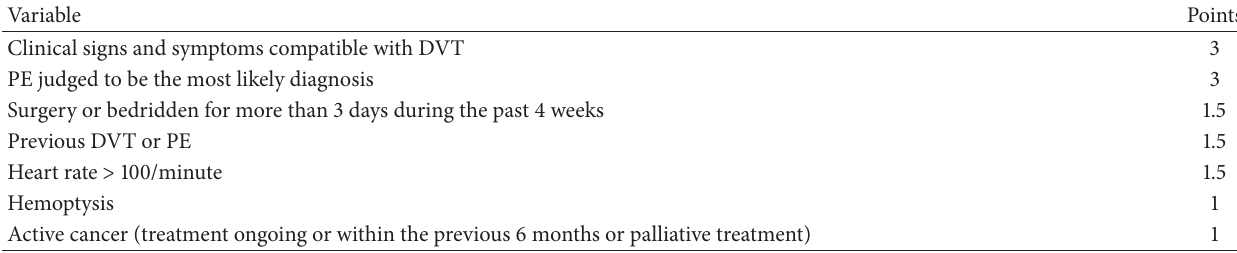
Table 2: Wells score for PE (adapted from